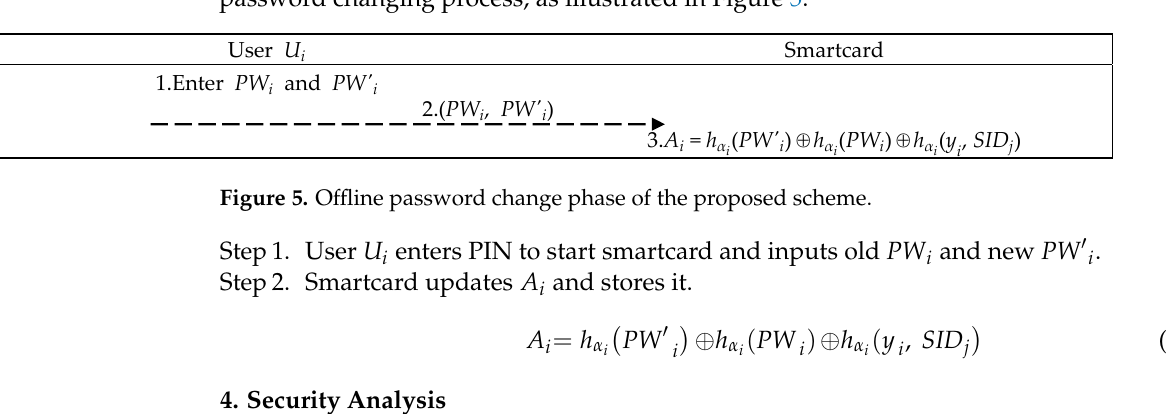
Figure 4. The authenticated key exchange phase of the proposed scheme.